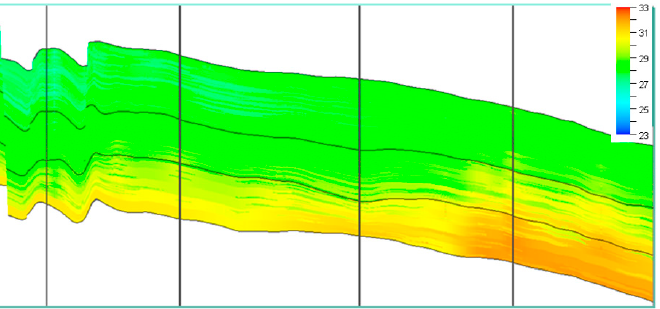
Figure 6. Cross-section map of minimum horizontal principal stress in the N–S direction.